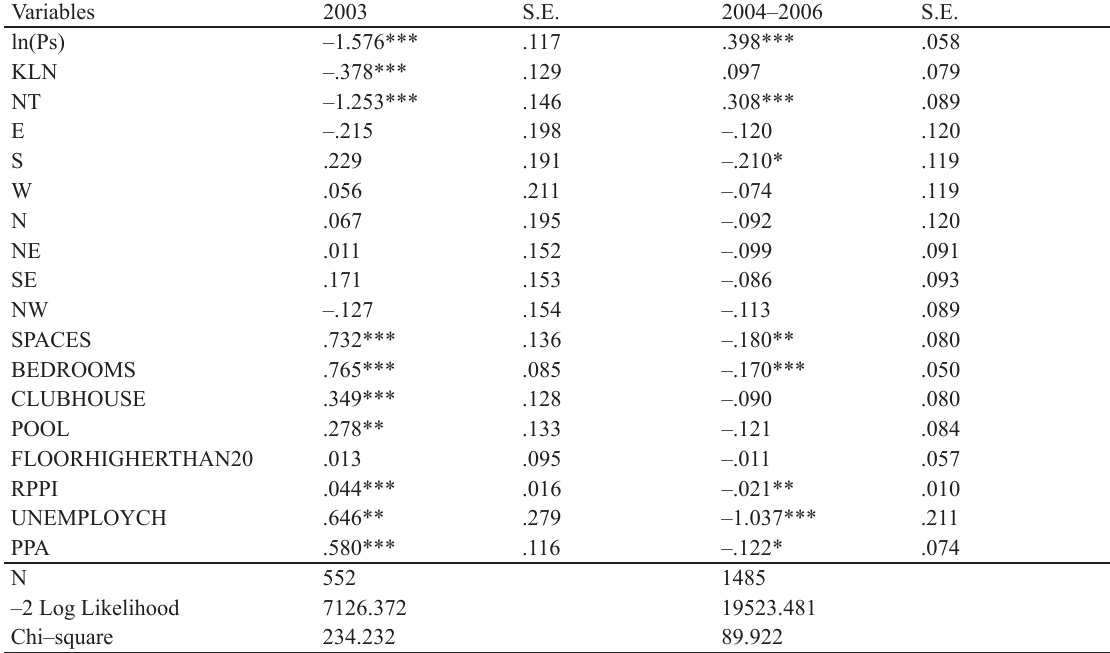
Table 5b. The Cox model results (vacant